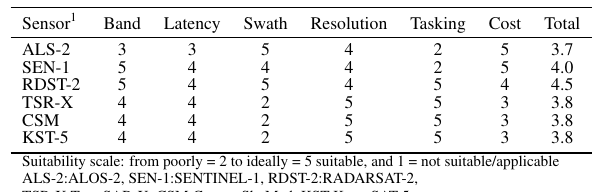
Table 2. Sensor Analysis for each OCIMS Requirement.